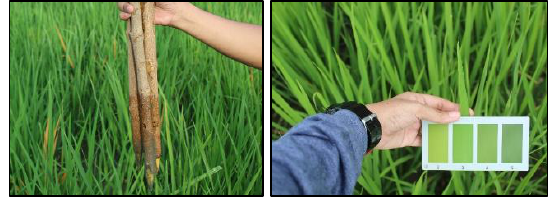
Figure 5. Stakes for marking sampling quadrants (left) and LCC measurement